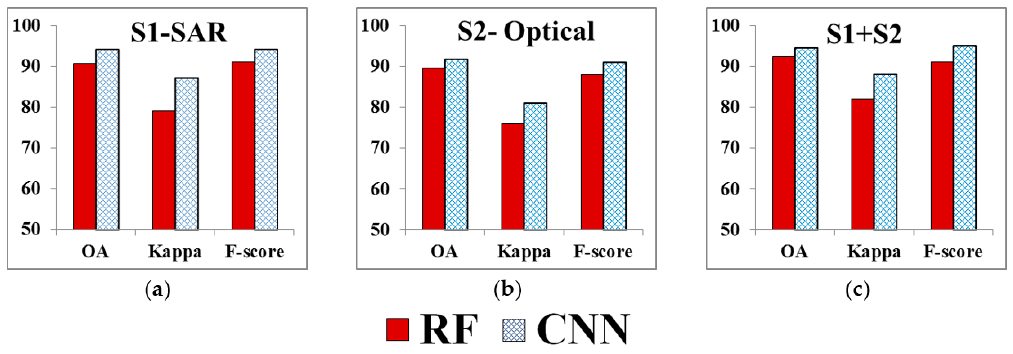
Figure 11. Comparison of accuracy indices between RF and CNN classifications in three different scenarios: ( a ) Using the S1 SAR data, ( b ) using S2 optical data and ( c ) using S1 SAR and S2 optical data.